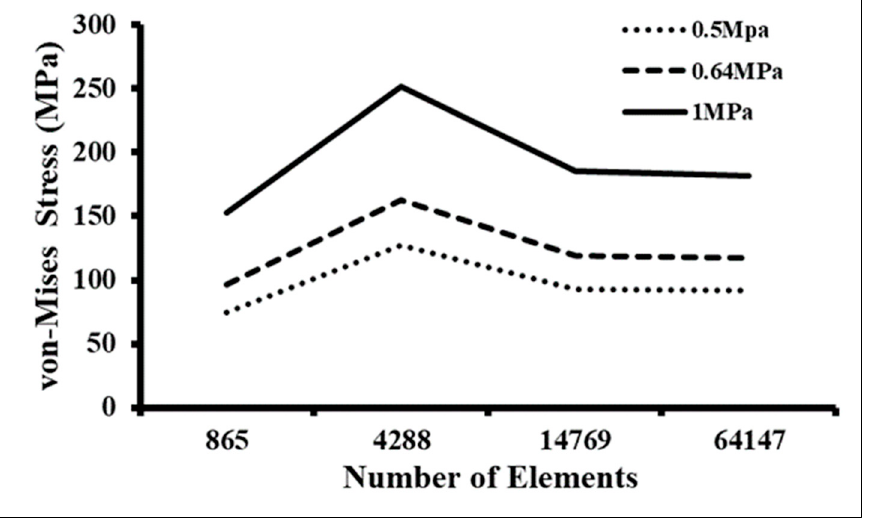
Figure 7. Mesh convergence study.